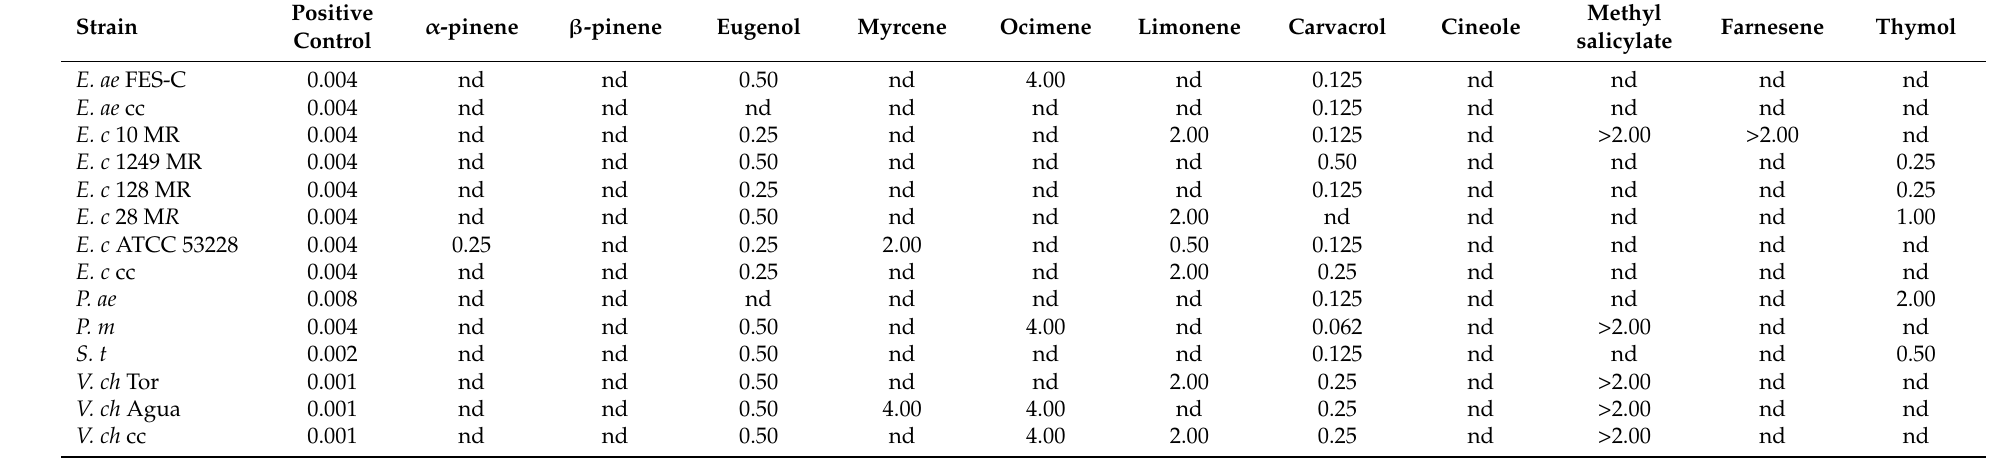
Table 5. Minimal inhibitory concentrations of some compounds in Gram-negative